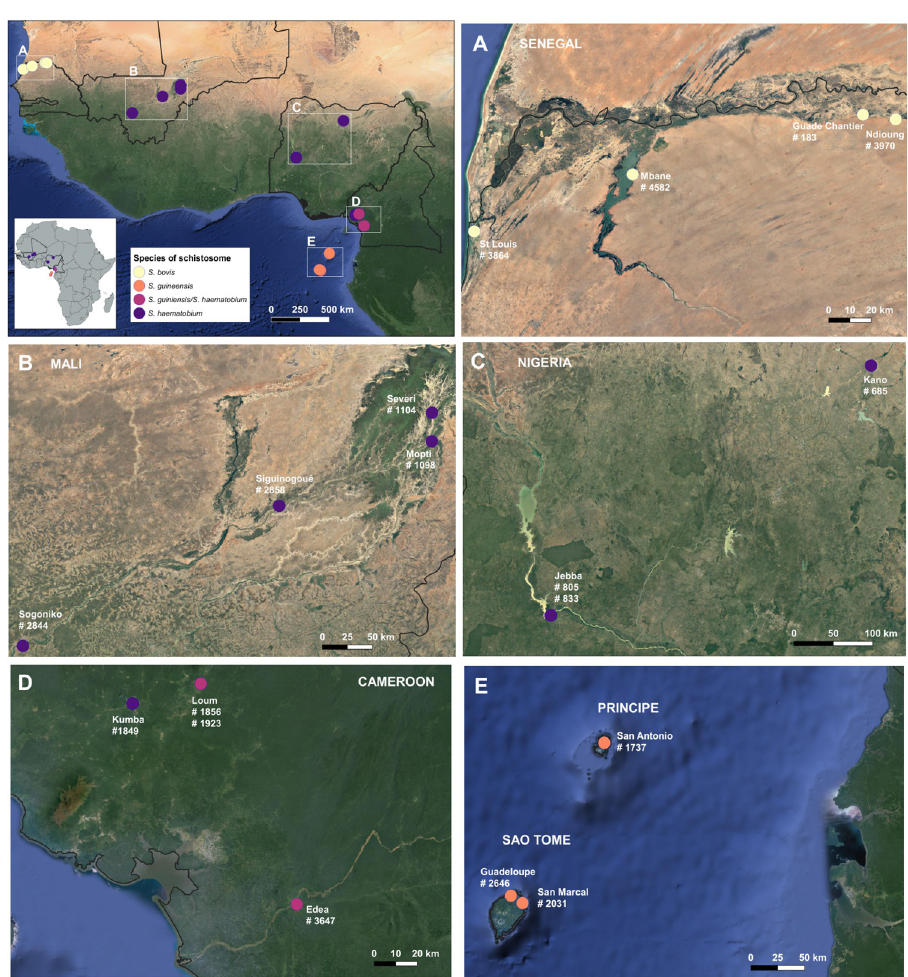
Fig 1. Geographic locations and the initial species identification of the isolates analysed. The map was created in Quantum GIS, version 3.14 (Pi), and the satellite layer sourced from ‘openlayers’ via the OpenLayers python plugin deriving from OpenStreetMaps Satellite data. Base-layer tileset were downloaded as follows: Mali Tile Bounds -8.30625, 12.45391, -3.97171, 14.69223; Senegal Tile Bounds -16.53588, 15.91597, -14.56542, 16.70207; Nigeria